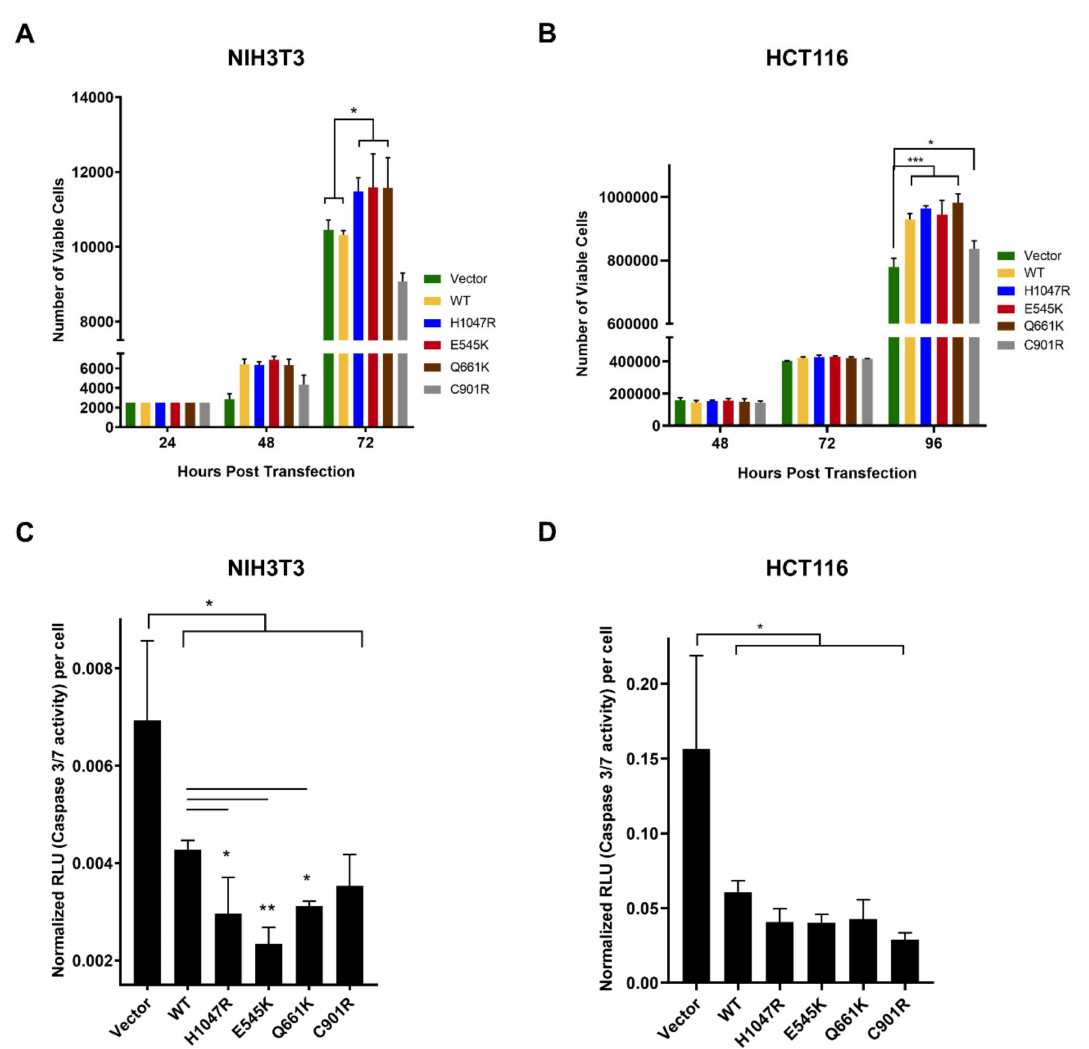
Figure 1. Variable e ff ects of wild type (WT), canonical, and novel PIK3CA mutants on proliferative capacity and apoptosis resistance in NIH3T3 and HCT116 cells. Proliferation rates of ( A ) NIH3T3 and ( B ) HCT116 cells, and caspase 3 / 7 activity in ( C ) NIH3T3 and ( D ) HCT116 cells transfected with empty vector, wild type PIK3CA, or PIK3CA mutants. Data presented are representative of three independent trials in triplicates and expressed as mean ± standard deviation. * p < 0.05, ** p < 0.01and *** p < 0.001. WT: wild